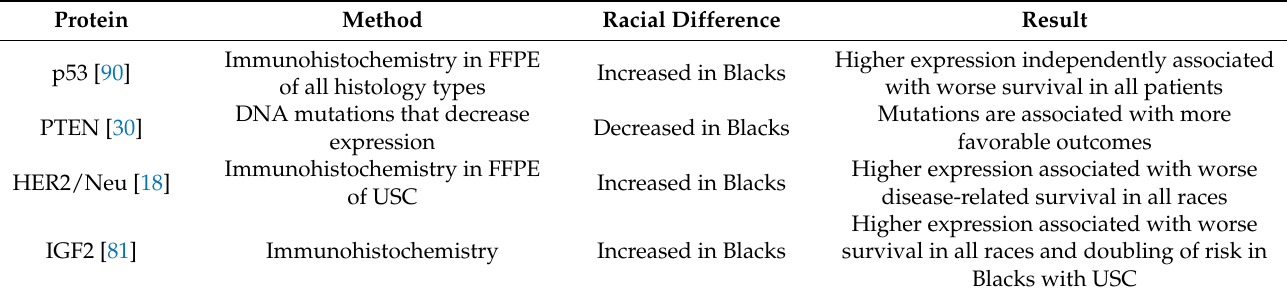
FFPE: Formalin-fixed,